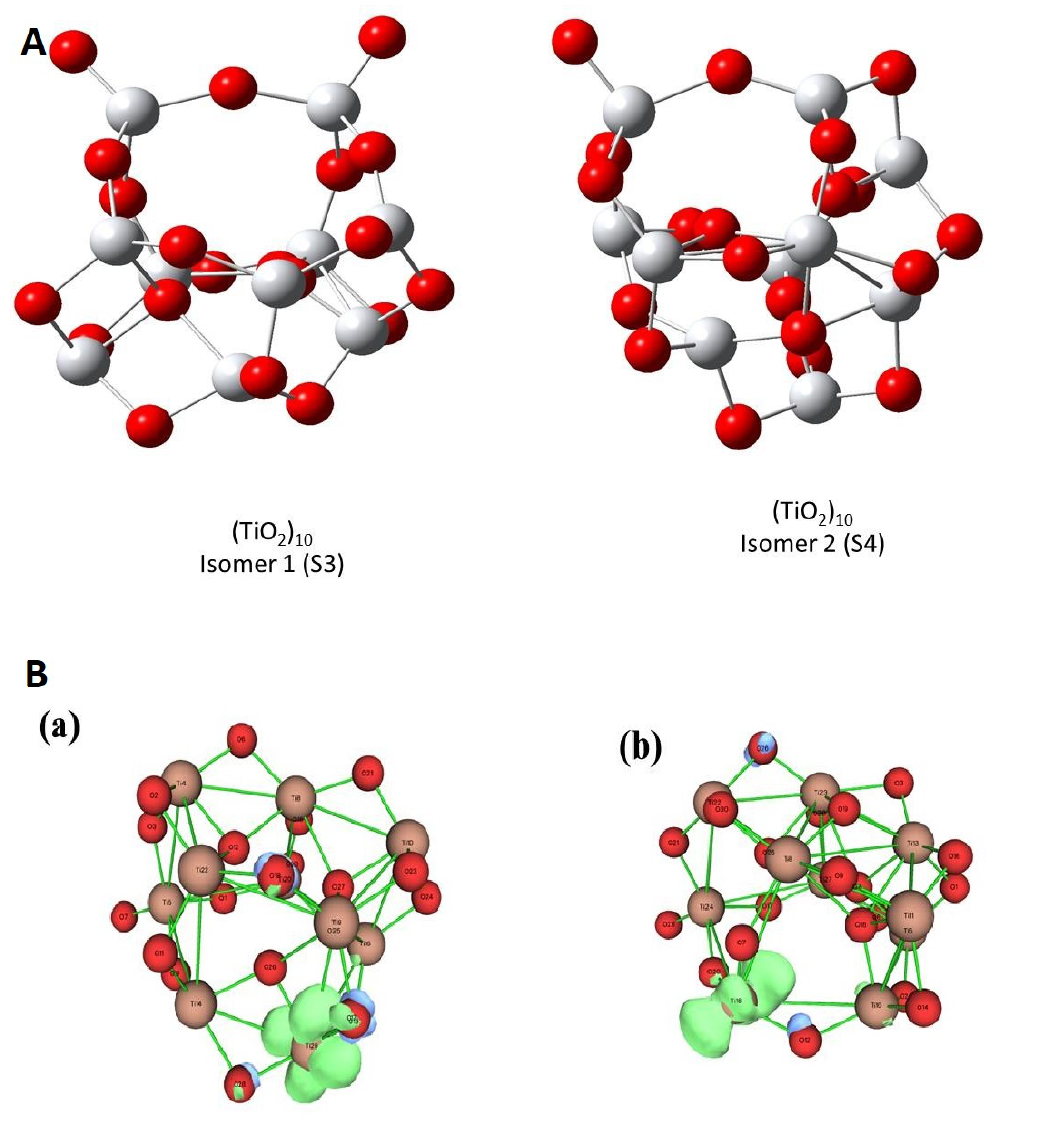
Figure 2. ( A ) Optimized structures of two isomers of (TiO 2 ) 10 labelled as S3 and S4. ( B ) Fukui functions ( f + S4 isomers ( b ) of (TiO 2 ) 10 cluster in gas phase. Red spheres represent oxygen and grey spheres represent titanium atoms,